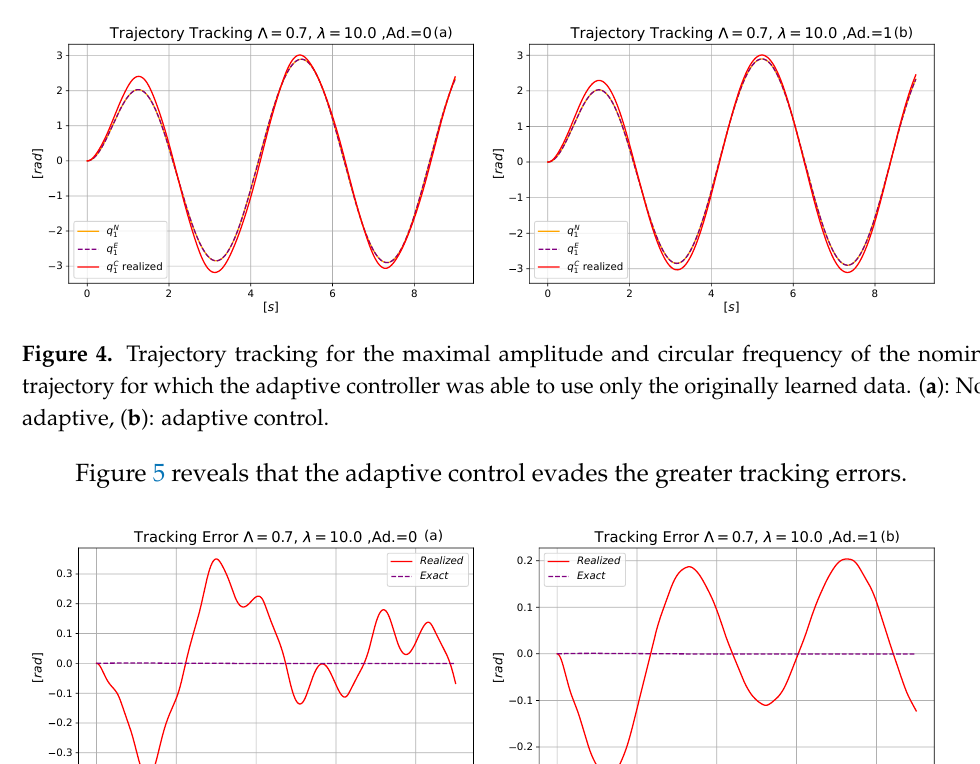
Figure 3. Examples of the abstract rotational angles stored in various grid points.